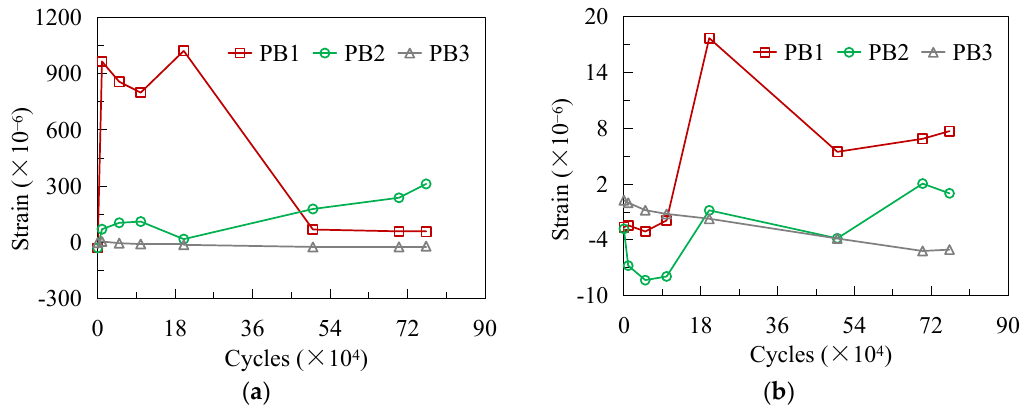
Figure 10. Strain development of PBL connectors under cyclic loading: ( a ) P min ; ( b ) P max .